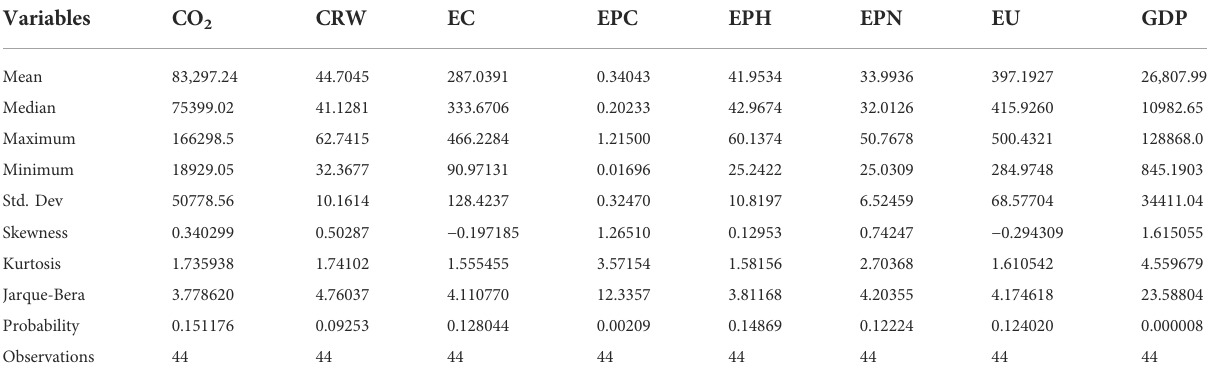
TABLE 2 Descriptive statistics analysis for all